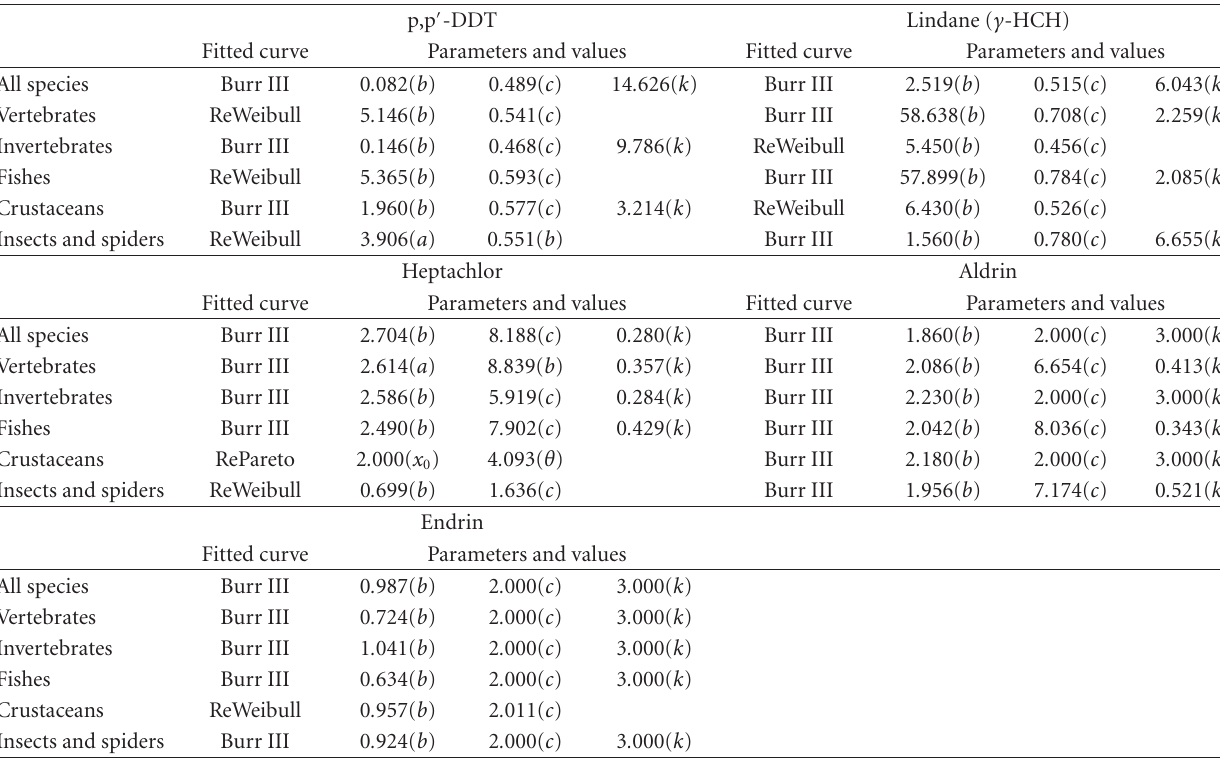
Table 3: The parameters of SSD curves calculated by BurrliOZ.